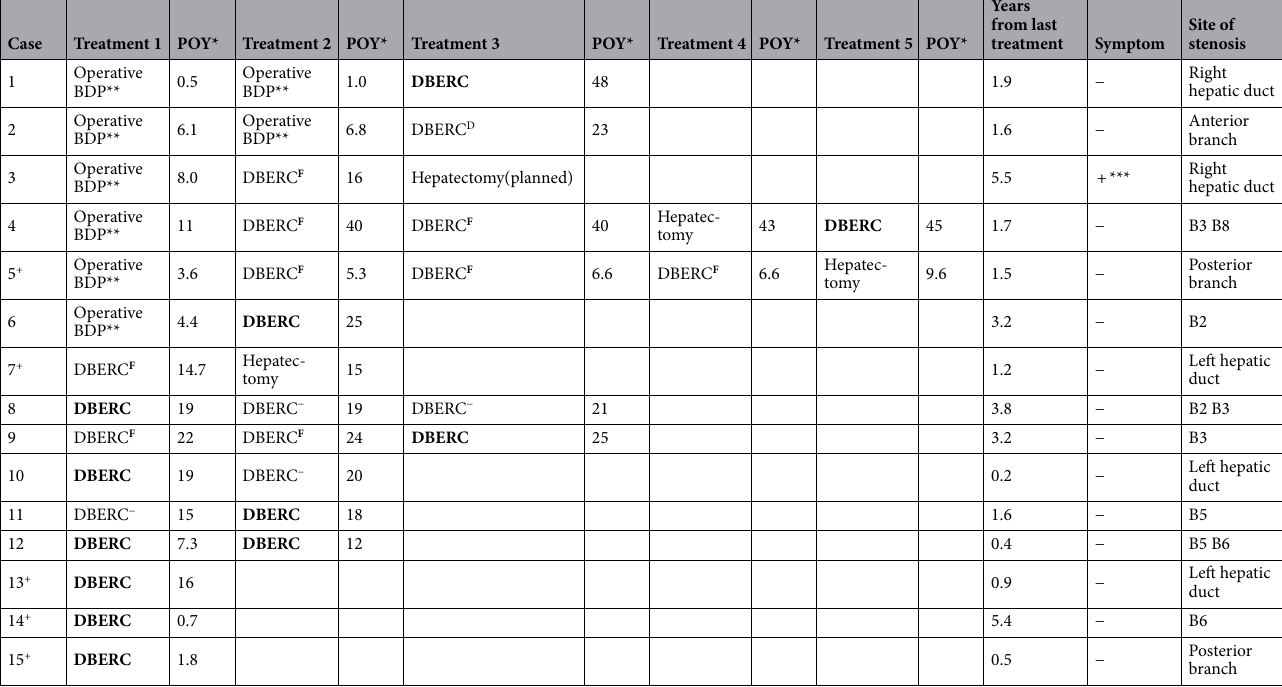
Table 2. Treatment history of 15 patients with bile duct strictures. Superscripted plus sign ( + ) beside the case number: bile duct plasty was performed at the time of the primary operation. DBERC : Complete lithotripsy. DBERC − : No stones and stenosis. DBERC F : Residual stones after DBERC. DBERC D : Stenosis without stones.